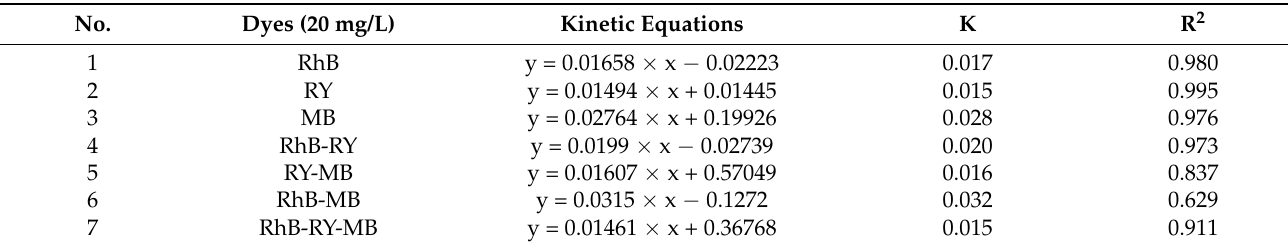
Table 2. Reaction kinetic parameters for photocatalytic degradation of different dye wastewaters measured by the PMTs method.